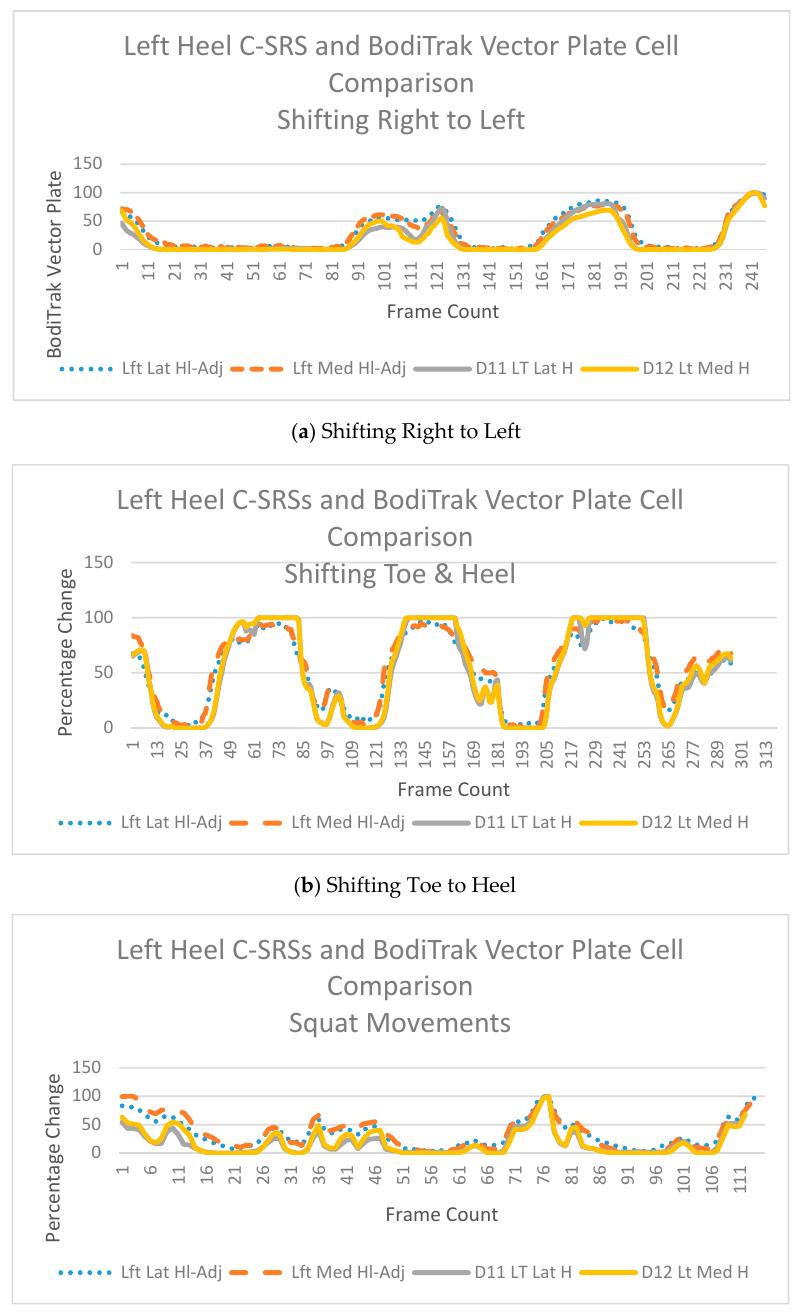
Figure 4. Sample data graphed to show percentage change comparisons of BodiTrak TM Vector Plate cells and left heel C-SRSs in the A/P orientation during ( a ) shifting right to left, ( b ) shifting toe to heel, and ( c ) squatting. The vertical axis represents percentage of change from minimum and maximum over horizontal axis of time. The blue line represents the left lateral heel sensor; the orange line represents the left medial sensor. The grey line represents the individual BodiTrak TM Vector Plate cell (D11) which correlates to the lateral left heel sensor. The yellow line represents the individual BodiTrak TM Vector Plate cell (D12) which correlates to the left medial sensor.